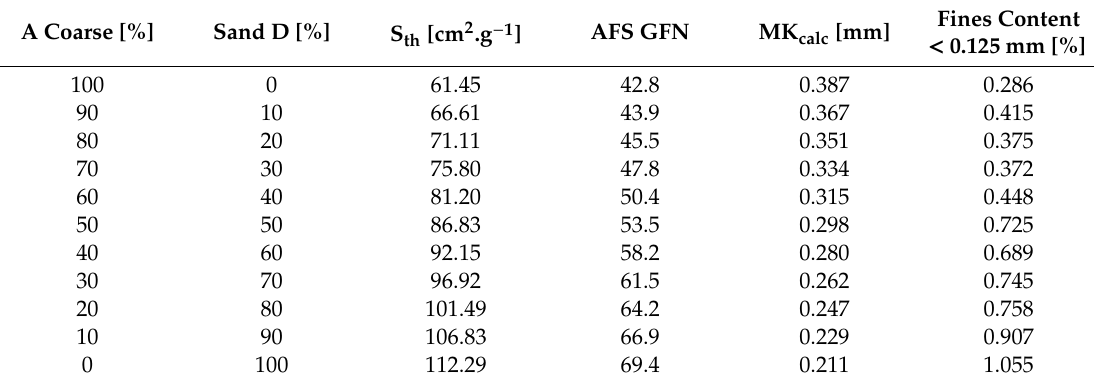
Table 5. Basic properties of sands A coarse and